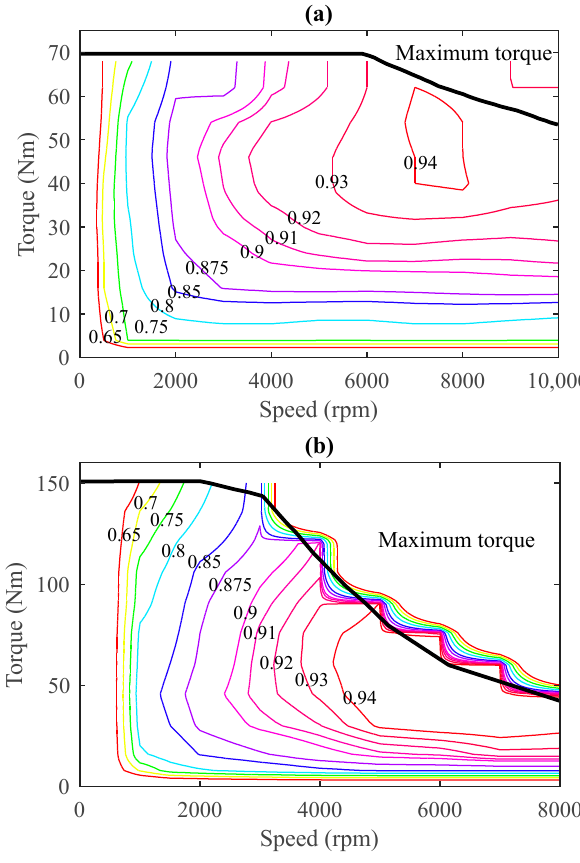
Figure 2. Motor e ffi ciency maps. Figure 2. Motor efficiency maps.